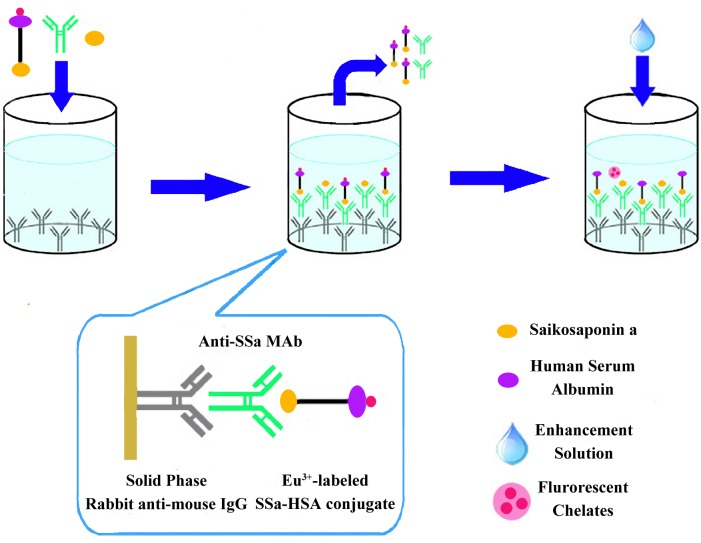
Schematic diagram of the TRFIA system for SSa detection.Rabbit anti-mouse IgG (“Y” shape in grey) was coated onto the plate; SSa (yellow oval dot), anti-SSa MAb (“Y” shape in green), and Eu3+ (red dot) -labeled SSa-HSA (purple oval dot) conjugate were mixed and incubated; after washing off of the extra reactants, the enhancement solution (blue drip) was added and the fluorescence intensity was measured.